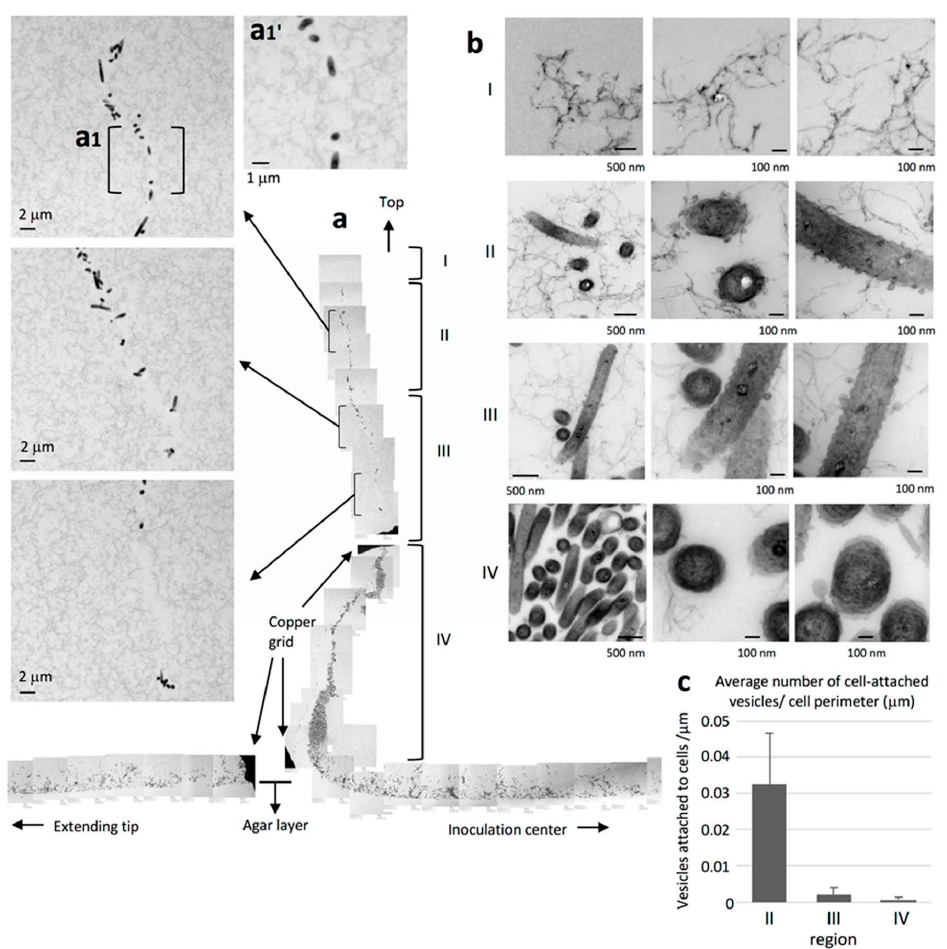
Figure 4. Strings of clustered WT bacteria protrude upwards, away from the main colony and the agar surface. WT colonies grown on 1% A-PY2 were aldehyde-fixed and embedded in Epon resin, and 70 nm sections were cut perpendicular to the surface of the agar medium and examined by TEM. Four distinct regions could be discerned. ( a ) Overview of the sections. Left panels: Higher-magnification images of region II and III in Figure 4a. Top panel: (a1 ′ ) Enlarged image of the area (a1) in Figure 4a. The filamentous background is traversed from top to bottom by a filament-less channel that contains many cells. ( b ) High-magnification images of regions I – IV. Region I is the highest in the marginal zone of the main colony and furthest from the agar plate. No bacteria are apparent; only fibers are observed at the leading edge of the biofilm. Region II: bacteria with many large vesicles and fibers surrounding the cells are observed at the top of the colony. Region III: bacteria with a few large vesicles surrounding them are observed. Region IV, just above the bottom bacterial layer: bacteria with a few small vesicles surrounding them are observed. Overall, the large intercellular space rich in filaments and vesicles in regions I – IV suggests mature biofilm formation in the WT colony. ( c ) The density of cell-attached vesicles per perimeter of cells (vesicles/mm) was measured. More vesicles were attached to the cells in region II than those in region III and IV (Figure 4b). Symbols on the graph represent the average density, and the error bars correspond to the